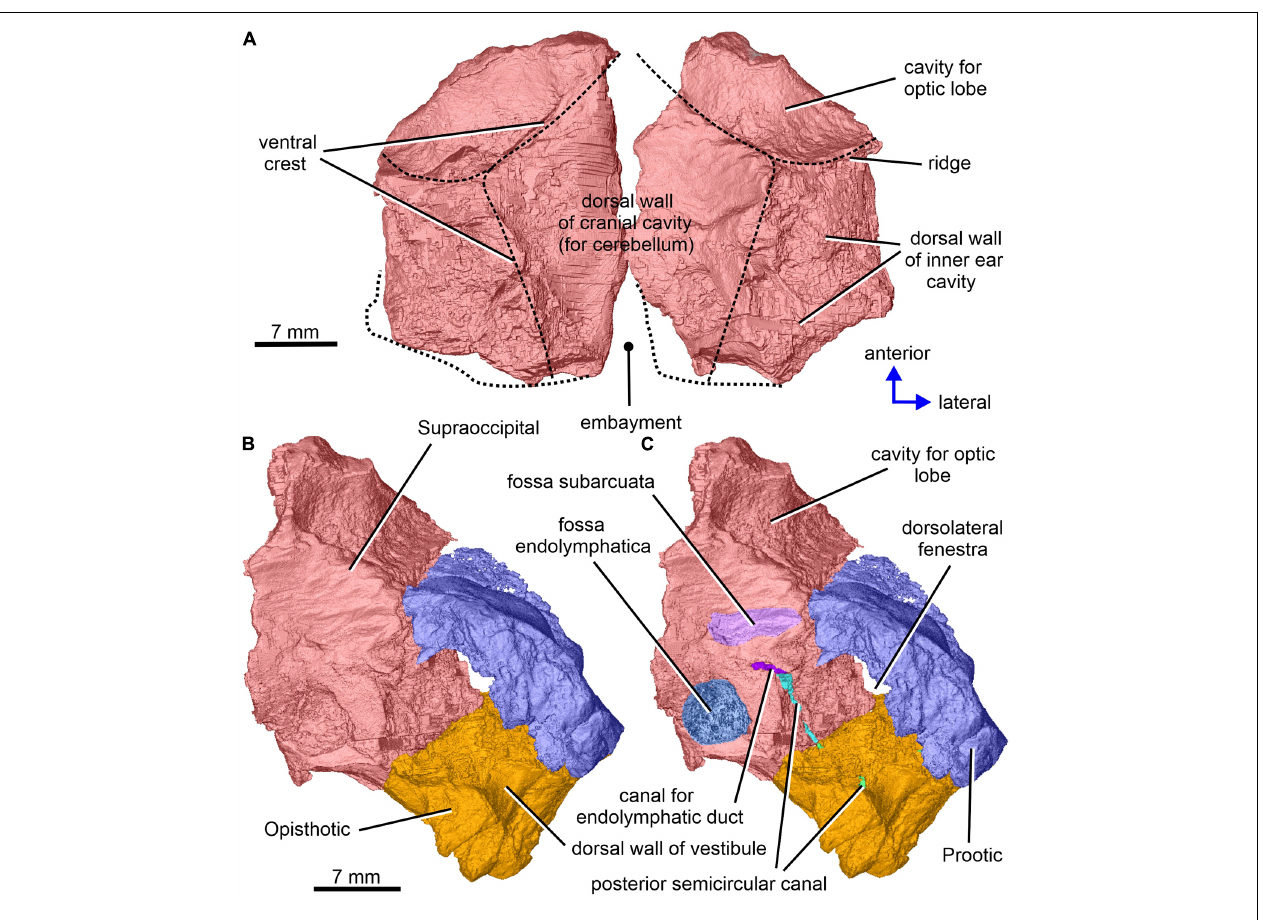
FIGURE 3 | Limnoscelis dynatis , CM 47653. (A) Supraoccipitals in ventral view. (B,C) Articulated left supraoccipital, prootic and opisthotic in ventromedial